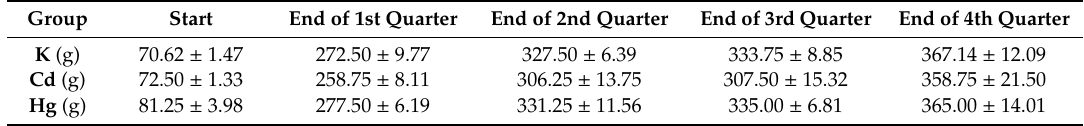
Table 1. Average weight of female rats ± SD.